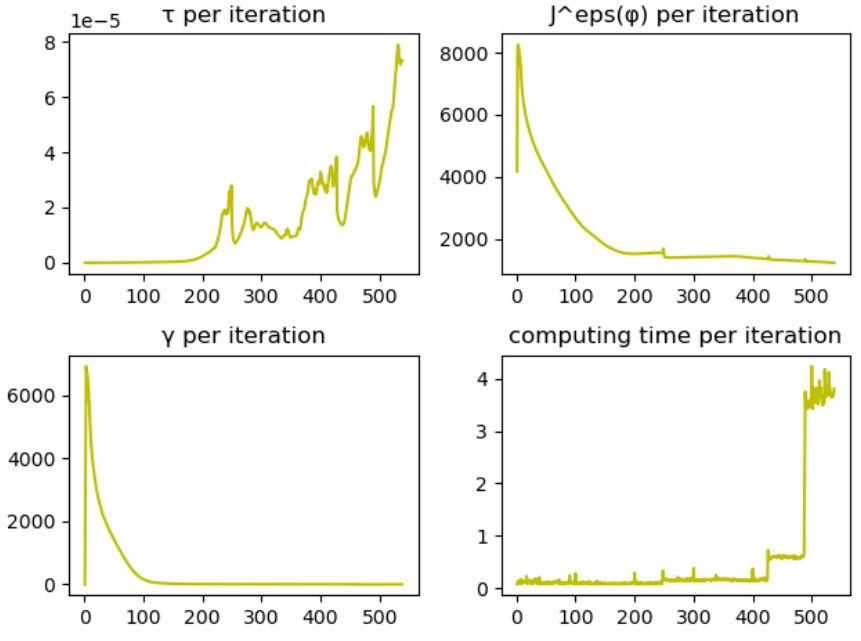
Figure A2. Metrics of the optimisation of Equation (4) using Algorithm